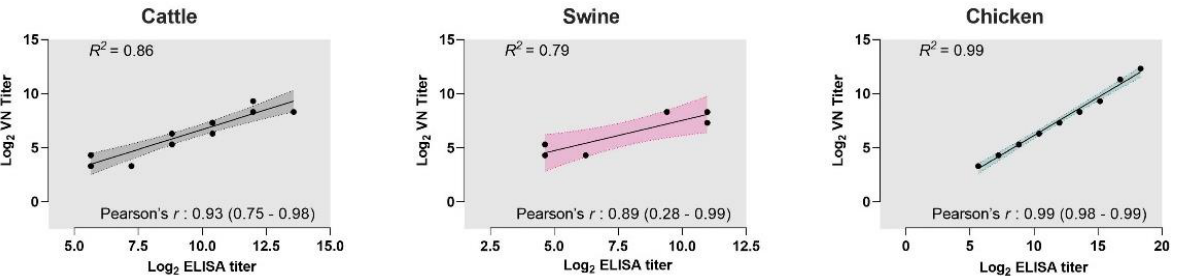
Figure 2. Correlation of cattle, swine, and chicken iELISAs with VNT. Correlation analyses were performed on the antibody titers from iELISAs and virus neutralization (VN) assays for each of the species: cattle, swine, and chicken. Strong correlation was observed between the titers from the assays (Pearson’s r: >0.8). Dots represent each sample of hyperimmune serum or IgY tested. Solid lines represent the linear regression curves of the titers of the samples analyzed by the assays. Shaded area indicates 95% confidence interval of the linear regression curve. R 2 is the correlation coefficient from the linear regression curve.